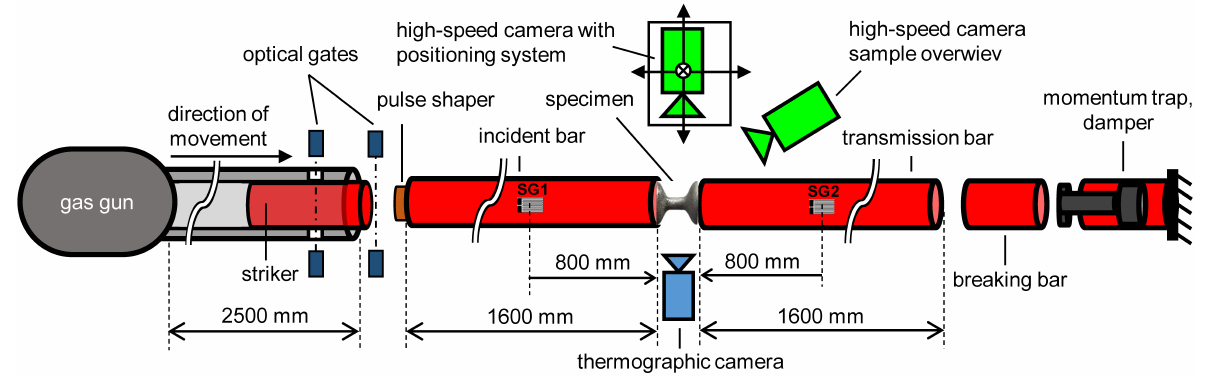
Figure 3. The arrangement of the SHPB experimental set-up: uni-axial compression with aluminium alloy